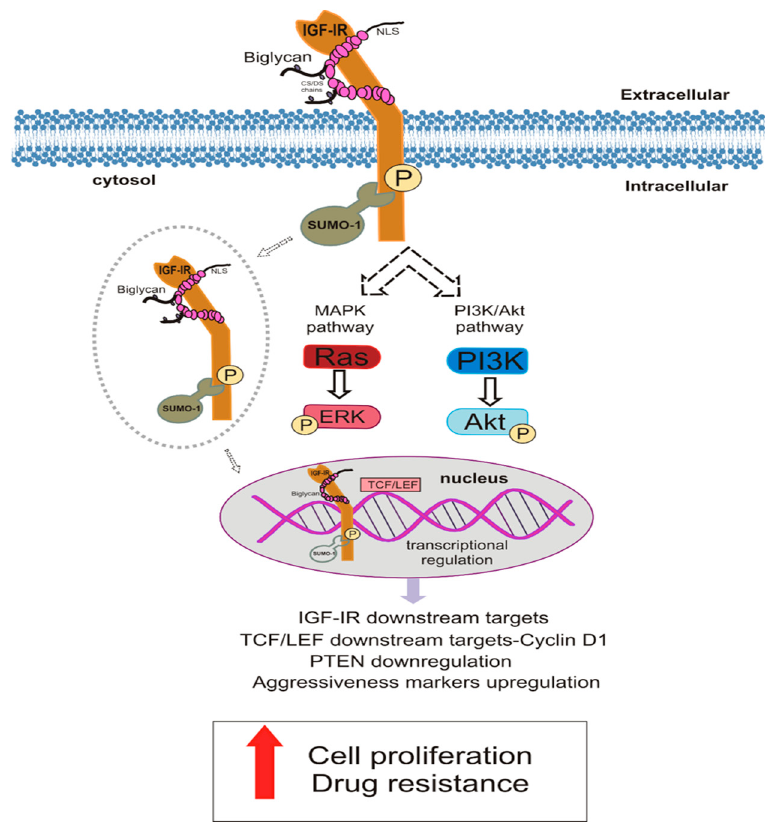
Figure 12. Biglycan interacts with IGF-IR to regulate osteosarcoma cells behavior. Biglycan binds to IGF-IR and activates the signaling cascade of the receptor. This complex formation stimulates the IGF-IR uptake to the cytoplasm, its sumoylation, and deposition to the nucleus where the receptor, putatively, acts as a transcriptional regulator or target genes. This mechanism involves biglycan in prolonged IGF-IR activation. The synergistic action of these molecules increases MG63 osteosarcoma cells aggressiveness, leading to enhanced growth and chemoresistance.